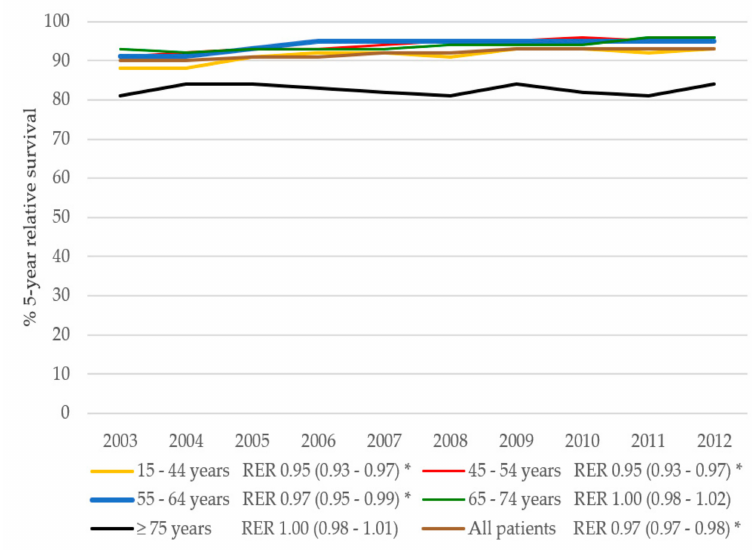
Figure 5. Five-year relative survival in BC patients over time per age group. RER indicates relative excess risk per year, adjusted for grade, stage, and treatment. * Significant ( p < 0.05). Similarly, the 5-year overall survival improved for all CRC patients (Figure 6). Overall survival in CRC patients was influenced by the year of diagnoses and age. Other factors a ff ecting 5-year overall survival were, stage, grade, gender, and treatment. The relative survival for CRC patients improved from 76.0% in 2003 to 80.3% in 2012 (adjusted RER 0.95, 95% CI 0.94–0.95 per year, Figure 7). Most overall improvement was observed in the CRC patients aged 65–74 years. In this group, the 5-year relative survival increased by 7.9% between 2003 and 2012 (adjusted RER 0.94, 95% CI 0.93–0.95). In contrast to the BC cohort, the RERs for patients with CRC in all age groups had improved significantly after adjustment for grade, sex, stage, and treatment (adjusted RERs varying between 0.94 and 0.96 per